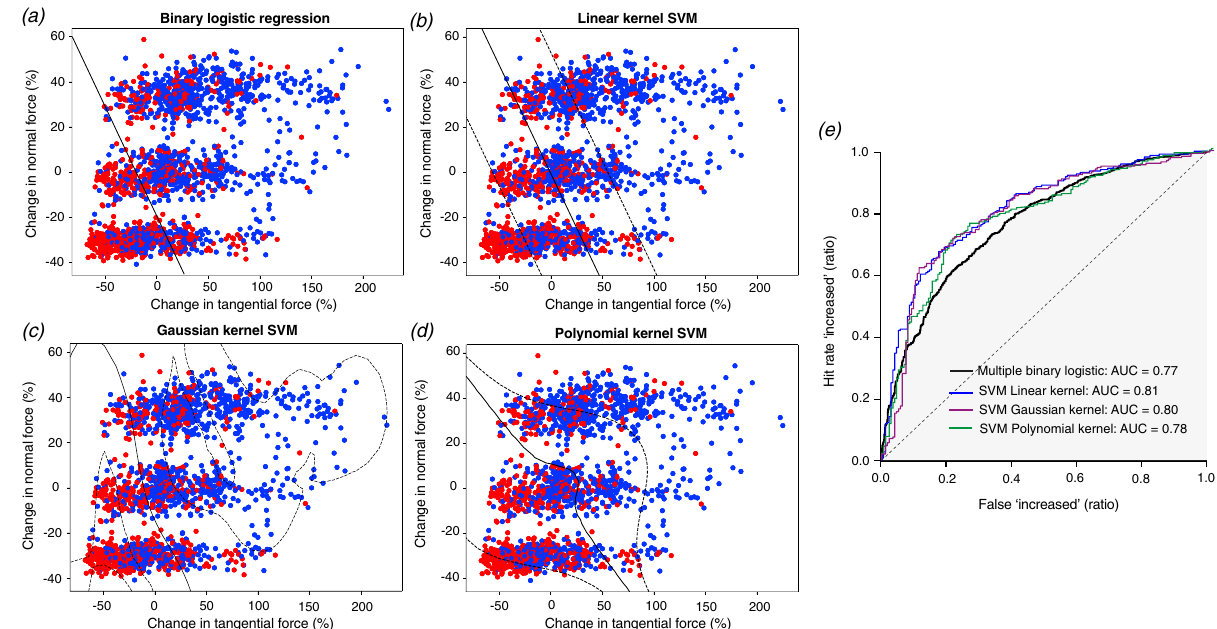
Figure 3. ( a ) The induced NF and TF changes during the modulated interval for all trials of the study and the classification line of the binary logistic regression. ( b ) Results for the linear kernel SVM with the addition of the 95% confidence interval boundaries. ( c ) Results for the Gaussian kernel SVM. ( d ) Results for the polynomial kernel SVM (degree = 3). ( e ) The receiver operator characteristic (ROC) curves obtained from the implemented